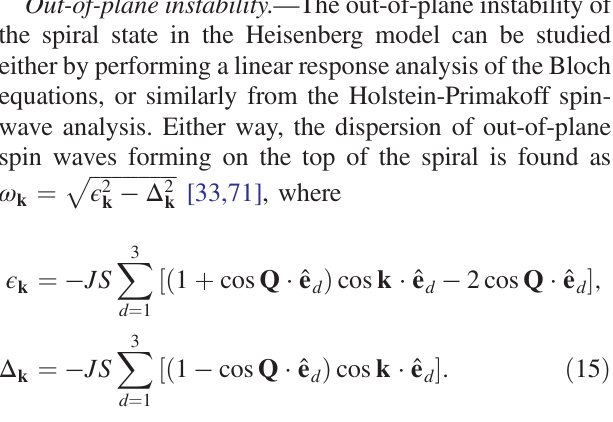
ˆ S z ˆ S z t Þ ¼ i χ zz;K t; t Þ as a function of the lattice wave vector k − k ið k ð ˆ S þ ˆ S − t Þ − k ið k